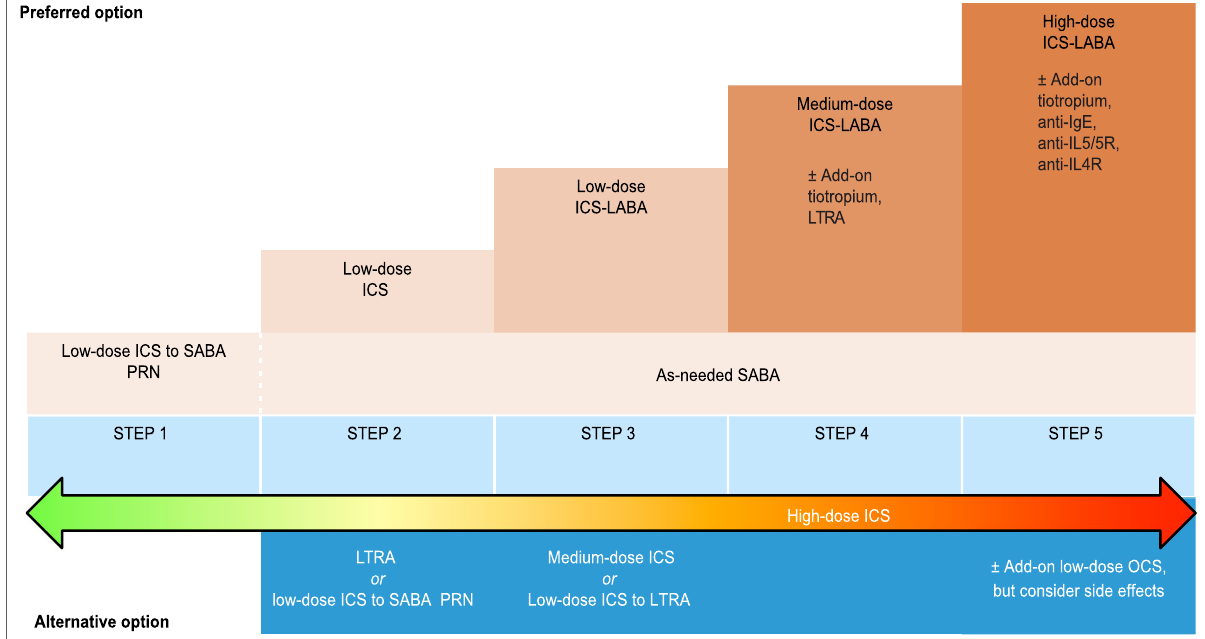
Fig. 7 Conventional approach. ICS inhaled corticosteroids, LABA long acting beta2 agonist, SABA short acting beta2